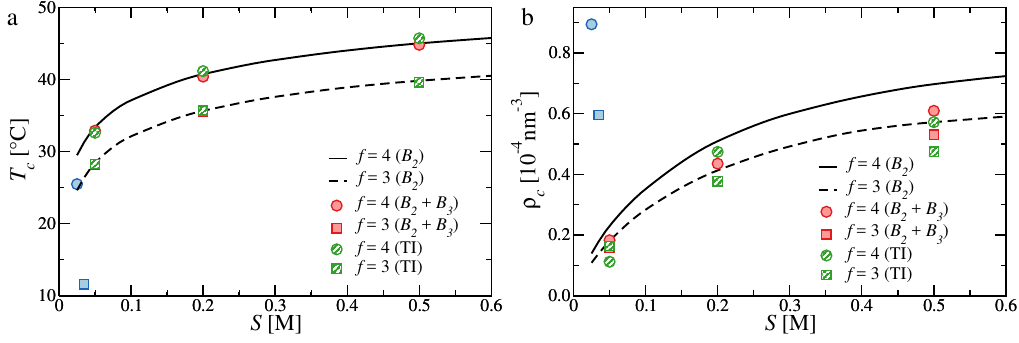
Figure 5. ( a ) Critical temperature as function of salt concentration. ( b ) Critical density as function of salt concentration. Circles and full line refer to tetramers ( f = 4); squares and dashed line refer to trimers ( f = 3). The data has been obtained with the second-order virial approximation [31] (black lines), the third-order virial approximation (full red symbols), thermodynamic integration (TI) (dashed green symbols) and experiments [8] (full blue